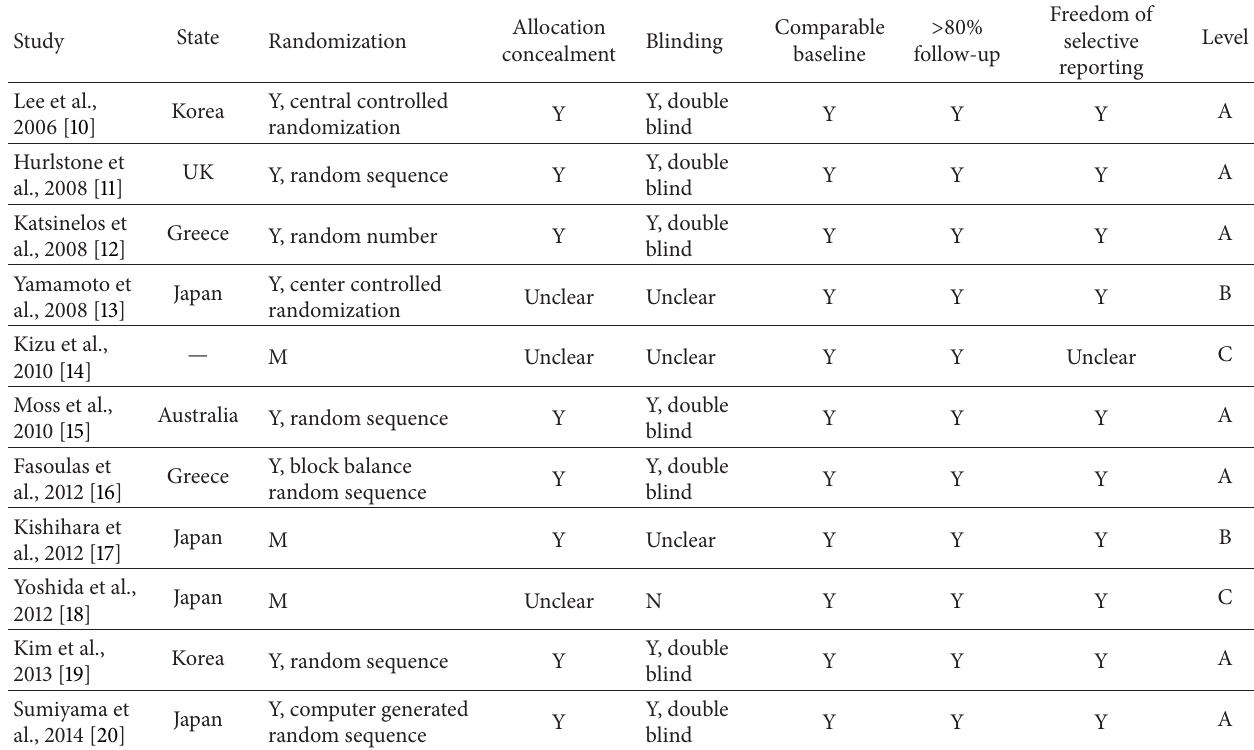
Table 2: Quality assessment of included randomized controlled trials.